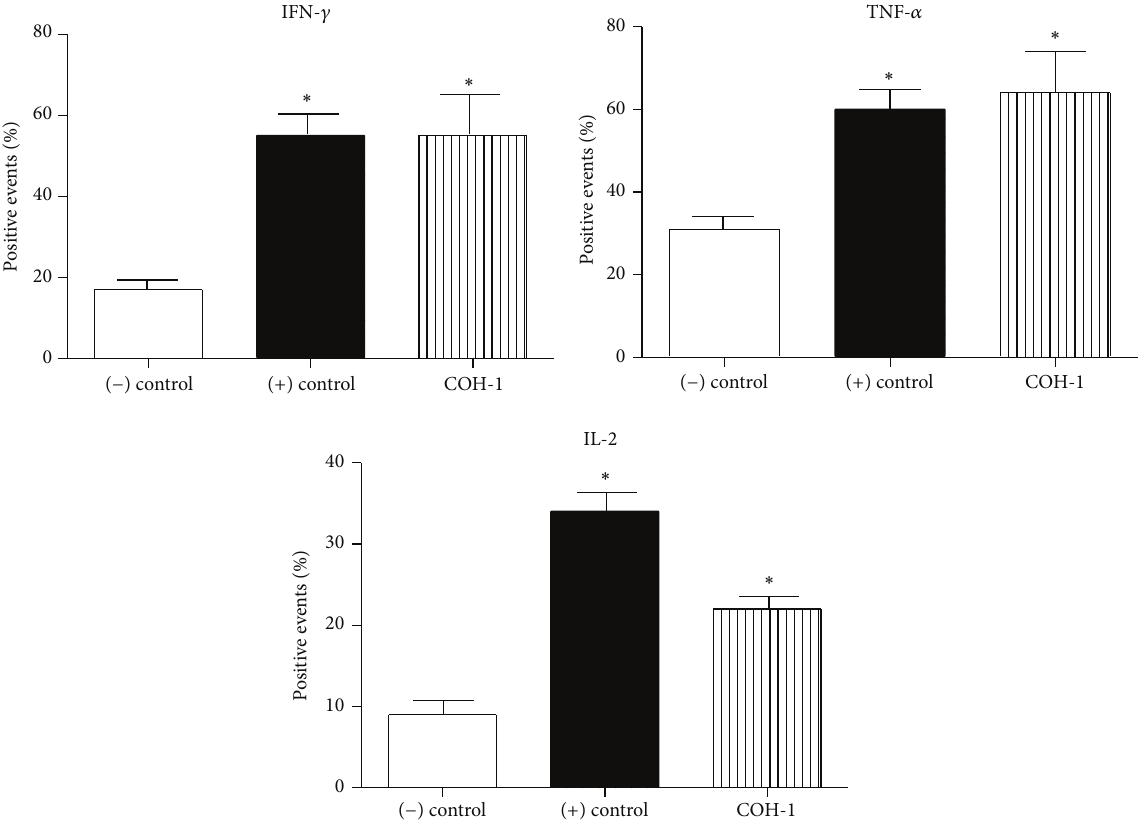
Figure 4: Ex vivo analyses of CD4 + T cell contribution to cytokine production. C57BL/6 mice were injected intraperitoneally with a dose of 10 7 CFU of wild-type GBS serotype III strain COH-1 ( 𝑛 = 3 per group × 3 individual experimental infections). Spleens were harvested 6h after infection and total splenocytes plated at 5 × 10 6 cells/well. After 4 h of incubation, the bacteriostatic agent chloramphenicol (12 𝜇 g/mL) was added to the culture to prevent cell toxicity. Nonstimulated cells from mock-infected animals served as negative ( − ) control for basal expression. Cells stimulated with Concanavalin A (0.1 𝜇 g/mL) were used as positive (+) control. Total splenocytes were incubated for 48 h. Brefeldin A (3 𝜇 g/mL) was added during the last 5h of incubation and CD4 + T cells were MACS-isolated from the culture, stained intracellularly for different cytokines, and analyzed by FACS. Data are expressed as means ± SEM (in % of positive cells) from 3 individual experimental infections. ∗ 𝑃 < 0.05 indicates statistically significant difference compared to ( − ) control cells. Twenty thousand gated events were acquired per sample and data analysis was performed using CellQuest software. Histograms were drawn based on PE-control stain and were plotted on logarithmic